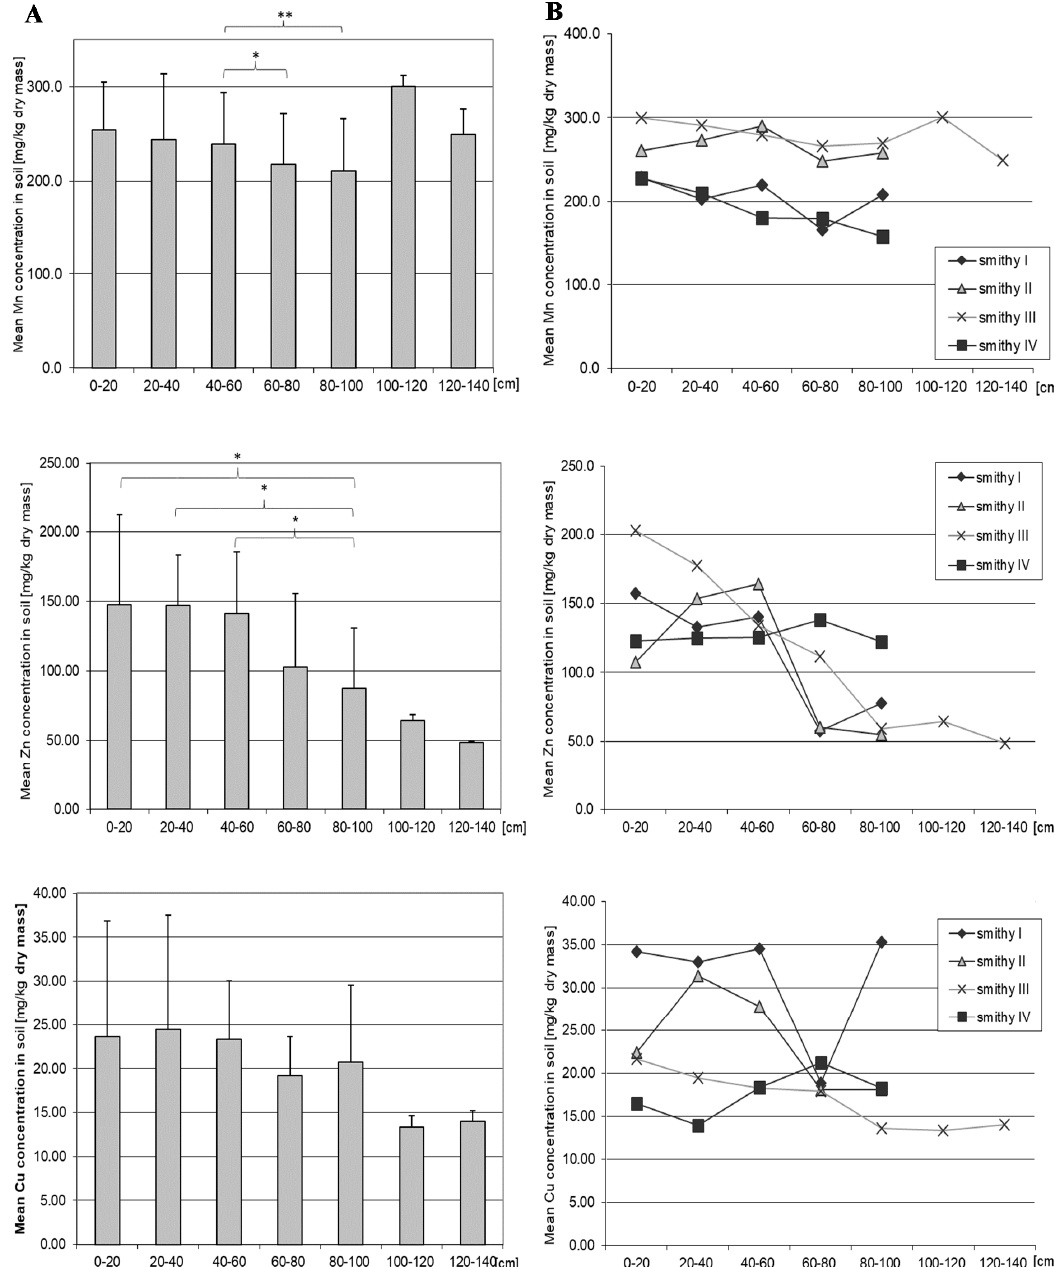
Figure 5. Mean concentrations of Mn, Zn, Cu in the soil depending on the depth of sampling ( A ) and depending on the site and the depth of sampling ( B ). Data represent the means ± SD for 3 independent measurements. * p < 0.05, ** p < 0.005 statistically significant differences in Mn and Zn concentration depending on the depth of sampling (Mann-Whitney U test). Statistically significant differences depending on the site of sampling (Wilcoxon test), see Supplementary Table S2.